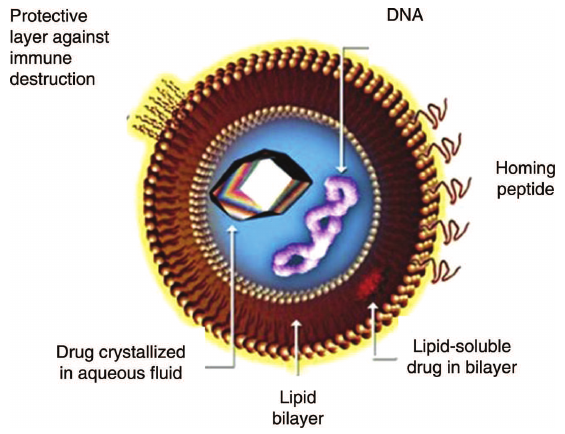
Figure 8: The structure of a liposome and its drug delivery mechanism. Image available at Ref.